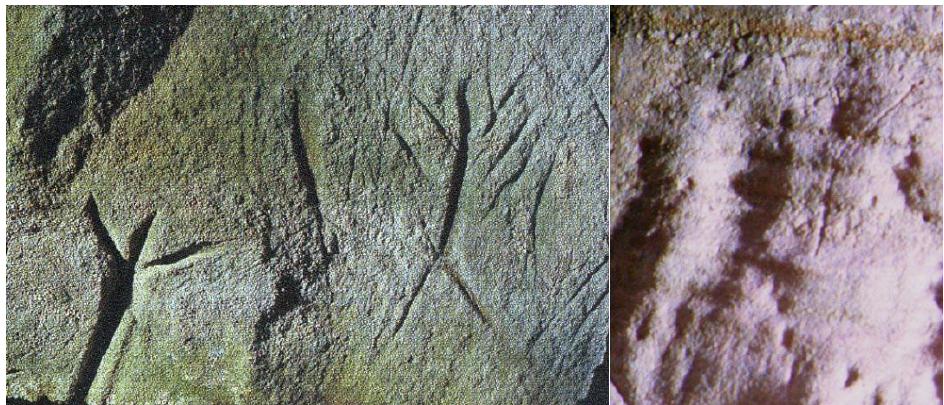
Figure 2. Examples of technique: abrasion (left) and pecking (right).